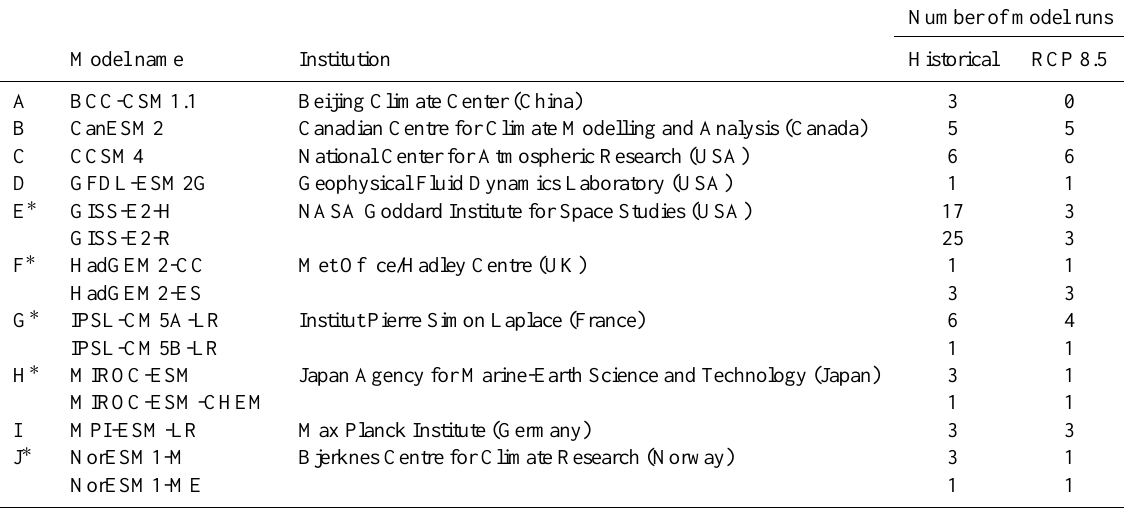
Table 1. CMIP5 models and number of simulations used in this paper for historical and RCP 8.5 runs. The first column provides the letter code used in the figures. References and details about soil carbon components are provided in Table